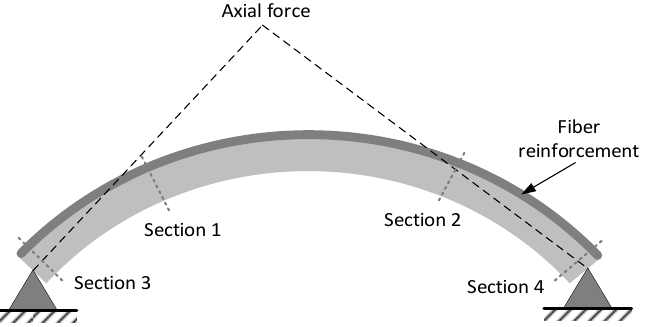
Figure 31. The position of four formations on reference arches and loading positions in the fourth arch [130].